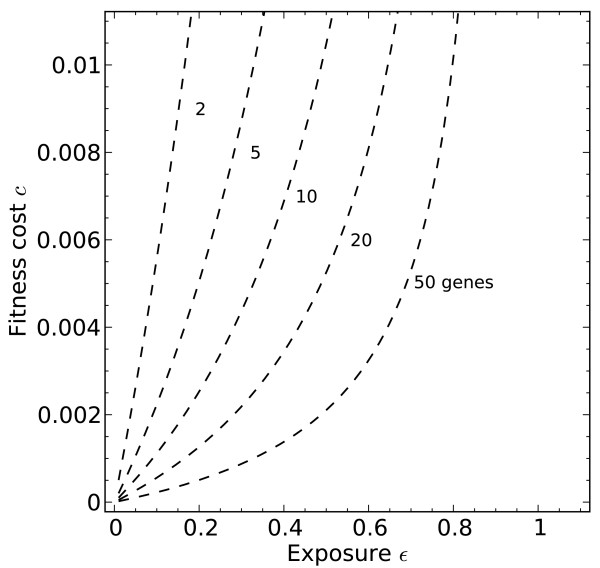
The pathway acquisition thresholdε∗(Equation (3)) shown as pathway lengthnvaries. This heuristic threshold relationship between c and εis dependent only on n and the fitness benefit b, which is set to b = 0.1.